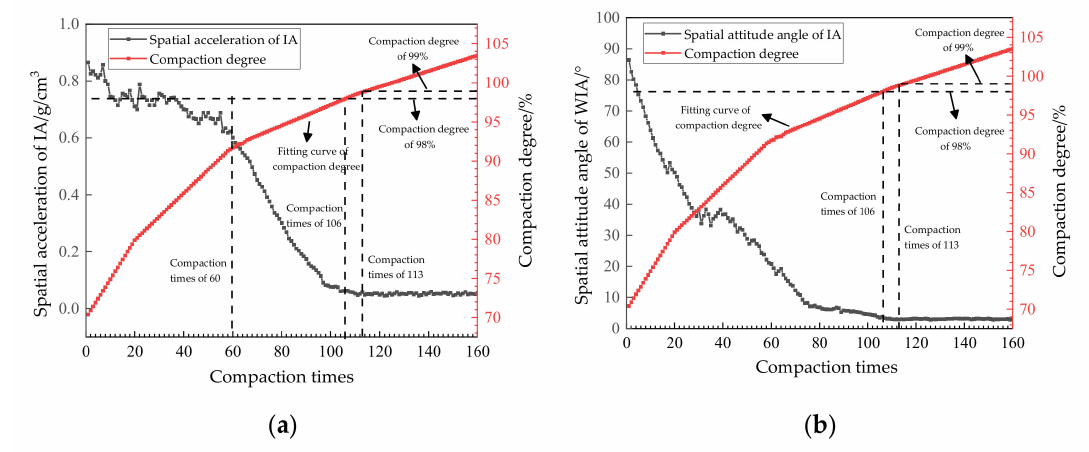
Figure 10. The relationship between the IA motion data and compaction parameters in the AC-25 asphalt mixture. Spatial acceleration ( a ) and Spatial attitude angle ( b ) of the IA in the AC-25 asphalt mixture.